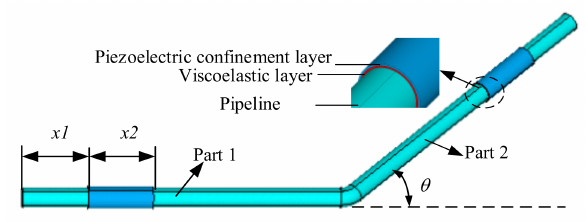
Figure 1. The finite element model for L-type pipeline.